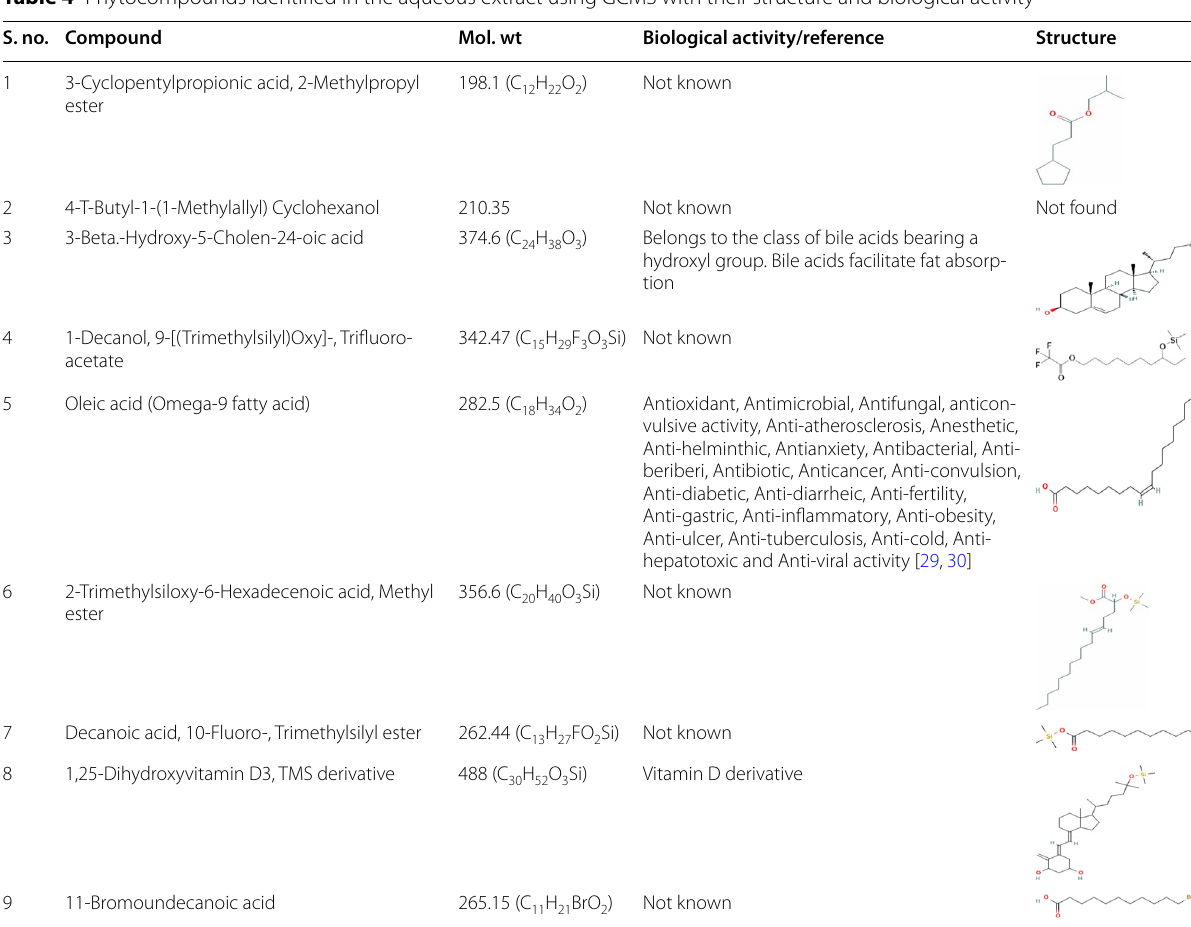
Table 4 Phytocompounds identified in the aqueous extract using GCMS with their structure and biological activity S. no.